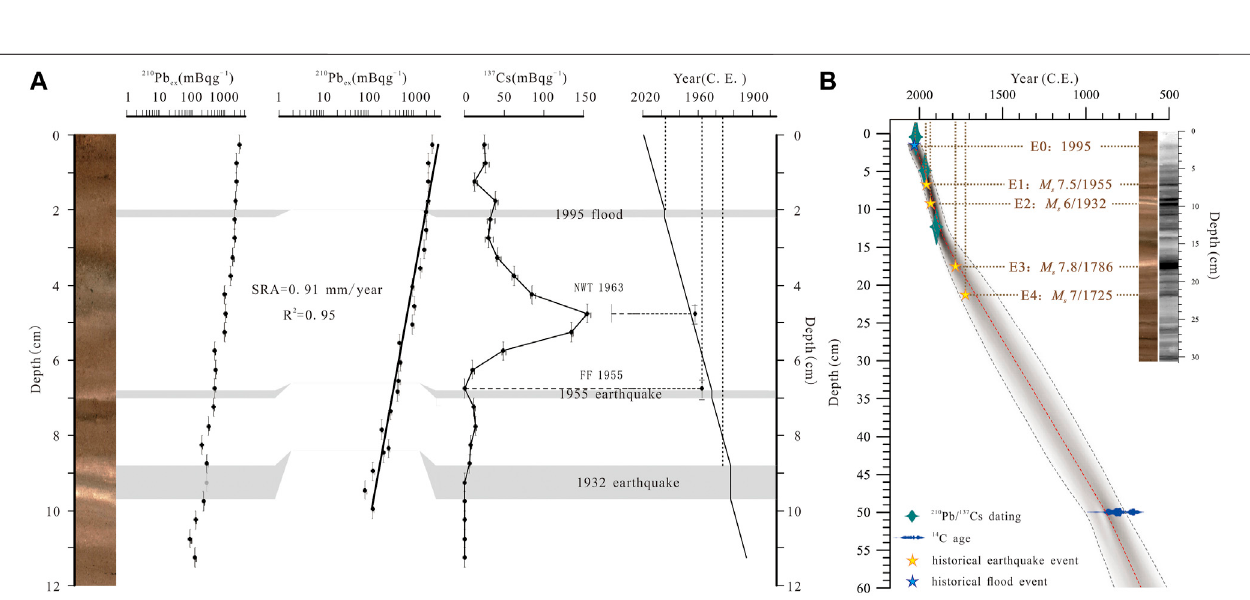
Frontiers in Earth Science |